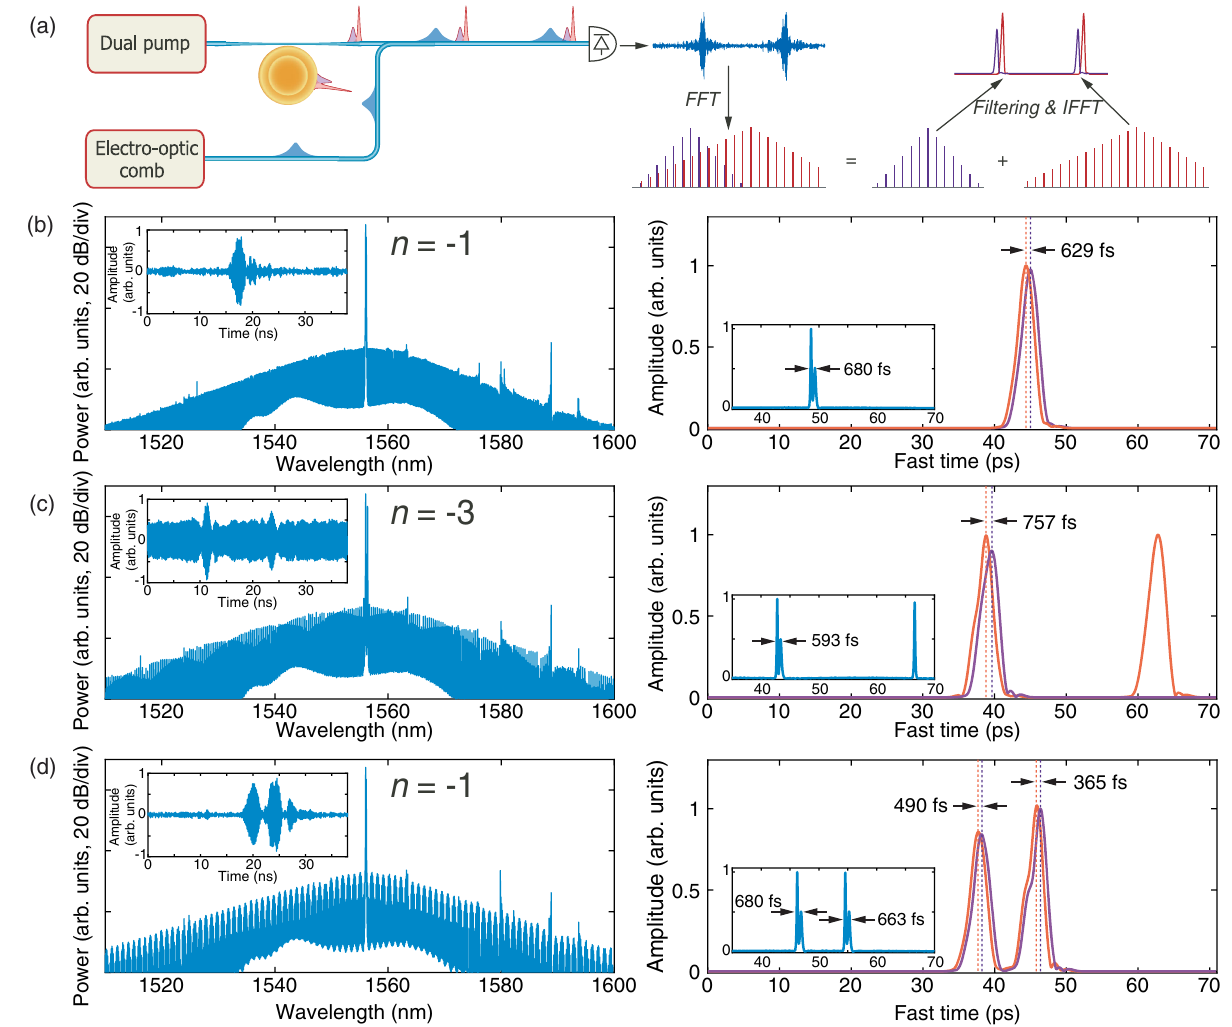
FIG. 3. Measurement of intersoliton separations. (a) Conceptual illustration of the process of determining intersoliton separations in composite solitons. Similar to the principle of the dual-comb spectroscopy, the EOC beats with the DKS at the receiving photodetector, generating interferograms [27]. Owing to the frequency offset between the primary and the secondary combs, the interferograms can be separated into the primary ones and the secondary ones, which allow the separations between distinct DKSs to be measured with a resolution that is much shorter than the temporal duration of the probing EOC pulses (see Appendix B for details). (b) – (d) The optical spectra of three composite solitons (left-hand panels) and the corresponding sampled structures (right-hand panels). The insets in the left-hand panels are interferograms sampled by the electro-optic comb. In the insets in the right-hand panels are the simulated temporal profiles. The measured and the simulated intersoliton separations are